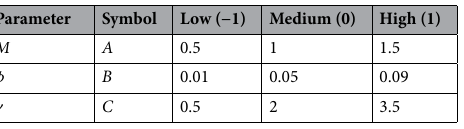
Table 3. Symbols and levels of experimental